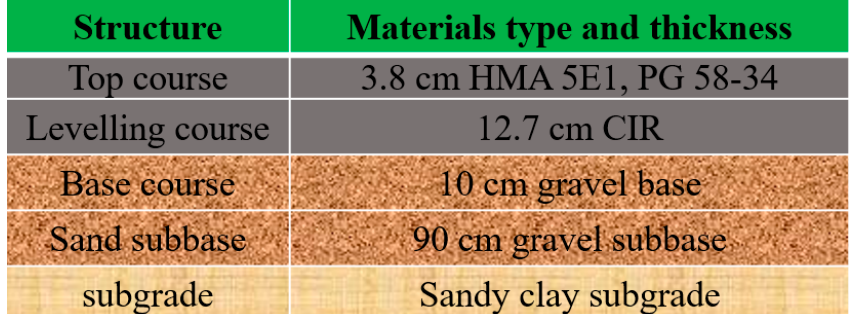
Figure 6. Demonstration of the structure and materials used in this study.